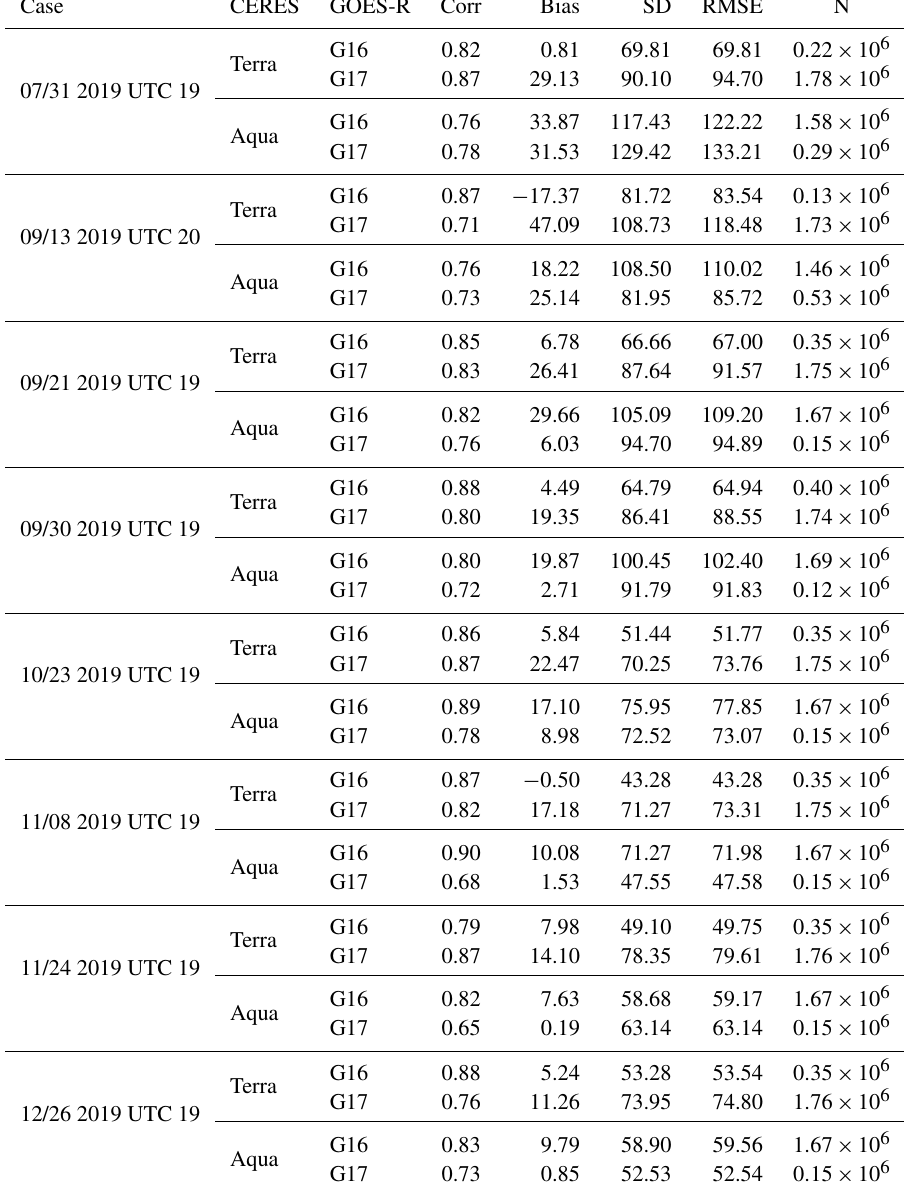
Table 7. Statistical summary for all selected cases intercompared at an instantaneous timescale.